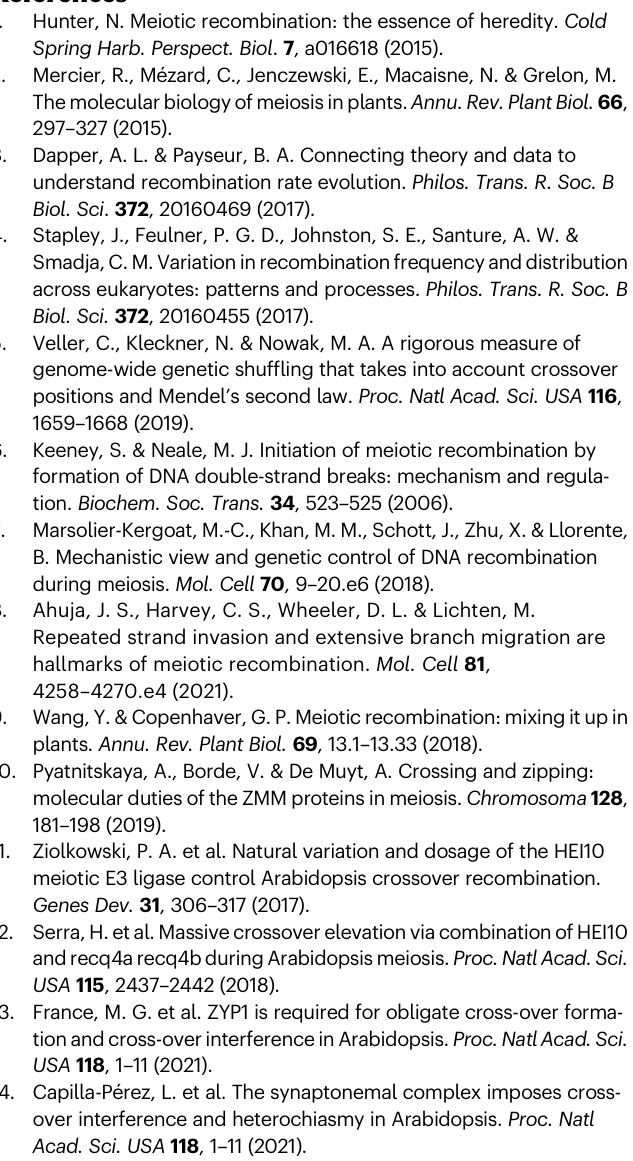
Table 8. Custom R script enabled comparison of the percentage of reads associated with reference (Col) or variant nucleotides in L er and C24 accessions. This has further allowed for genotype determination at particular SNP location and manual designation of CO